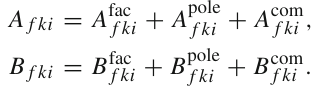
and one half of diagram III, while the u -channel contribution corresponds to diagram IIb